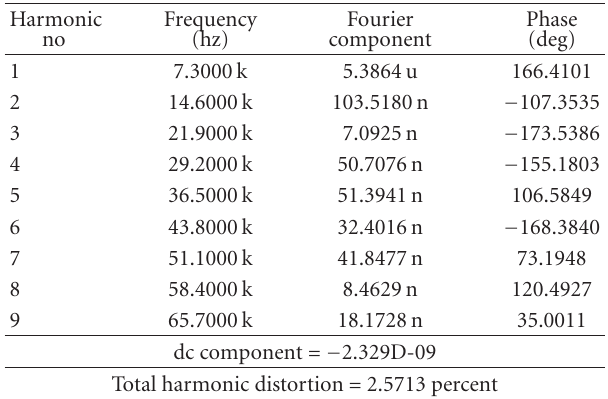
Table 2: Total harmonic distortion analysis of I o 1 in Figure 3.